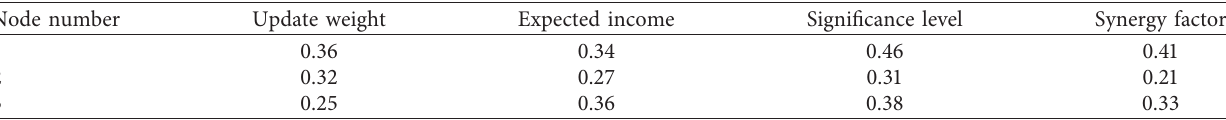
Figure 2: Low-carbon innovation algorithm process. Table 1: Attribute distribution of network knowledge sharing